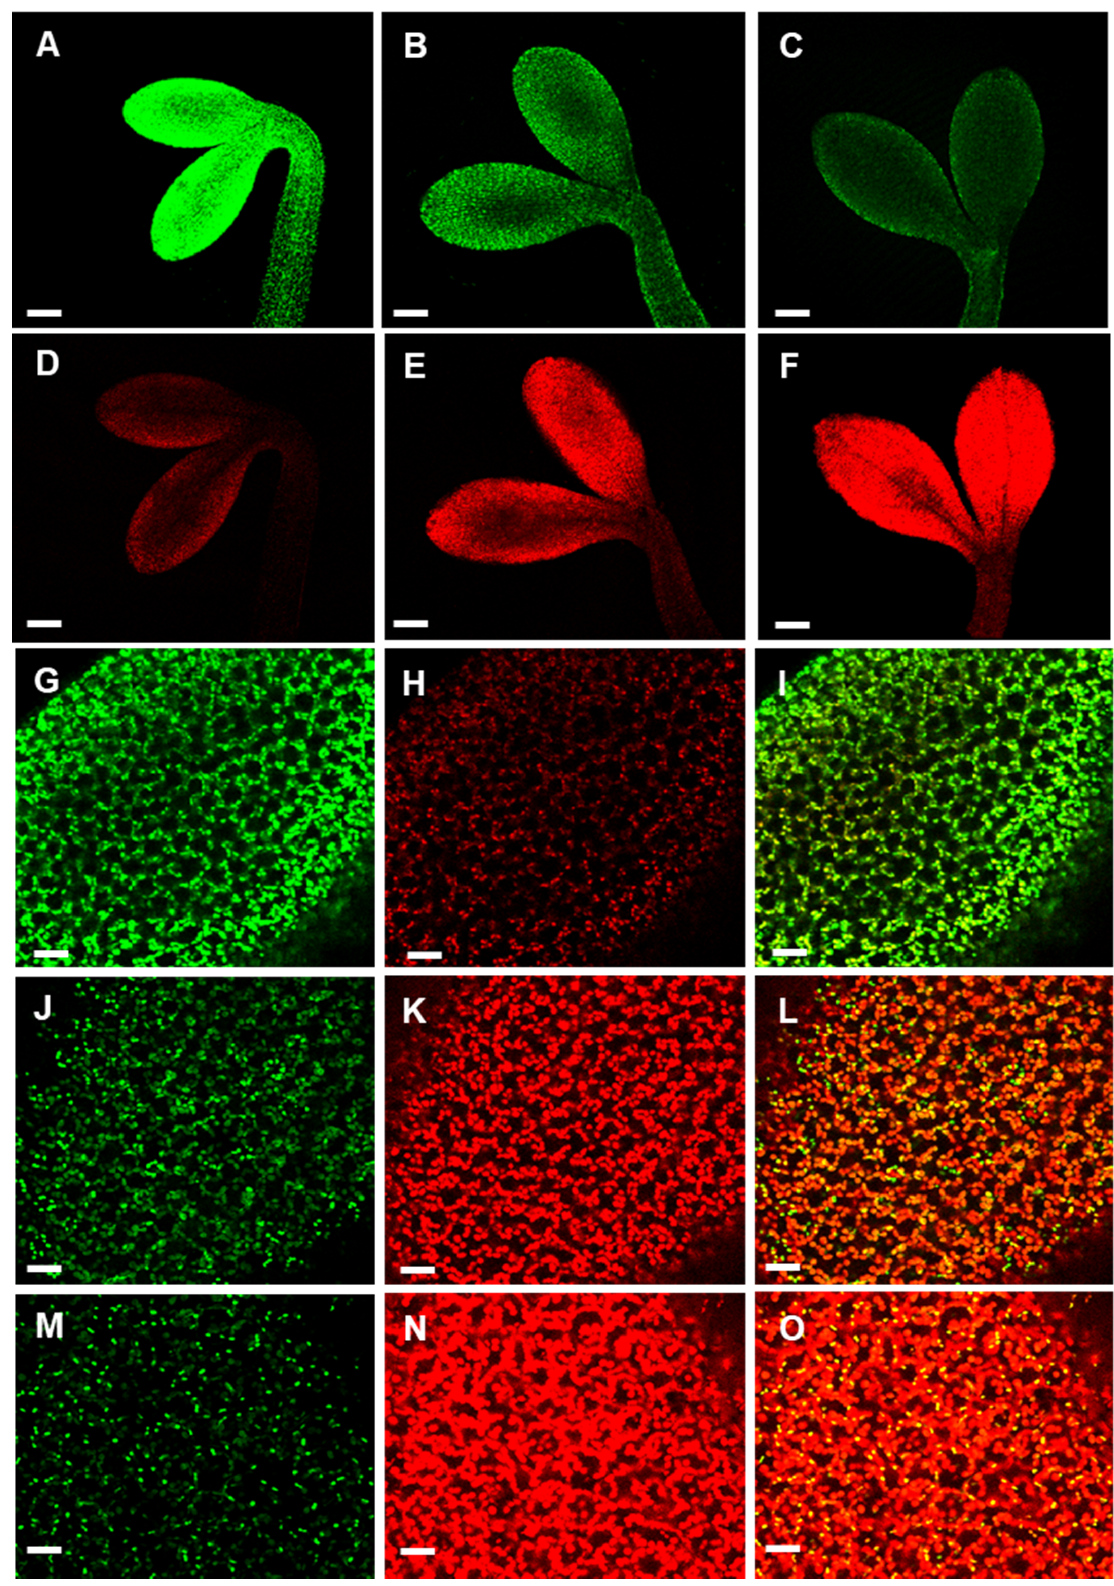
Figure 6. Time-course of light-induced APx-R-YFP degradation. Confocal z-stack images from two-day-old At APx-R-YFP OE seedlings germinated in the dark and exposed to light for: 0 h ( A , D , G – I ); 2 h ( B , E ); 6 h ( C , F , J – L ); and 20 h ( M – O ). Magnification ( A – E ) 20× objective; and ( G – O ) 60× objective. APx-R-YFP fluorescence is shown in green ( A – C , G , I , J , L , M , O ); and chlorophyll autofluorescence in red ( D – F , H , I , K , L , N , O ). Scale: ( A – F ) 200 µm; and ( G – O ) 30 µm.